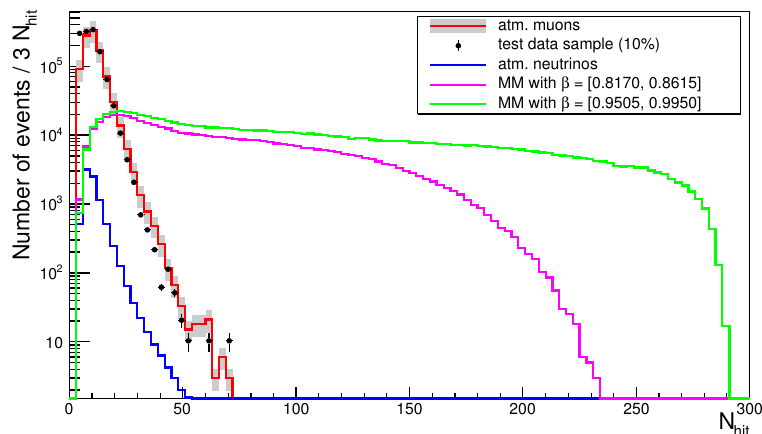
Figure 4 . N hit distribution for atmospheric muons (red histogram) with an uncertainty band of 35% ((cid:12)lled in gray), atmospheric neutrinos (blue histogram) and data (points with error bars). For comparison, the distributions of N hit for MMs simulated in the velocity ranges [0 : 8170 ; 0 : 8615] (magenta histogram) and [0 : 9505 ; 0 : 9950] (green histogram) are also shown. At high velocities, N hit provides a good discrimination for MM signals after applying the cuts zenith (cid:20) 90 (cid:14) and t(cid:31) 2 (cid:20) b(cid:31) 2 .